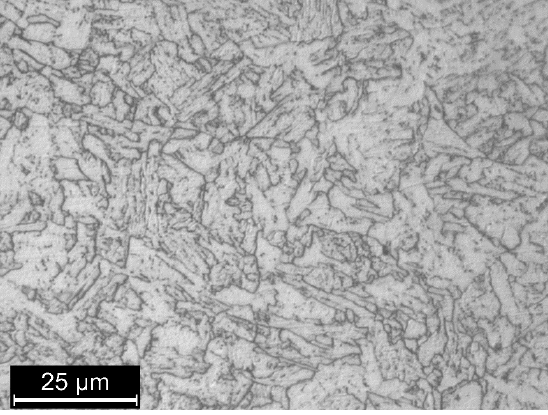
Figure 1. Microstructure of X65 grade steel after metallographic etching (Nital 2%).